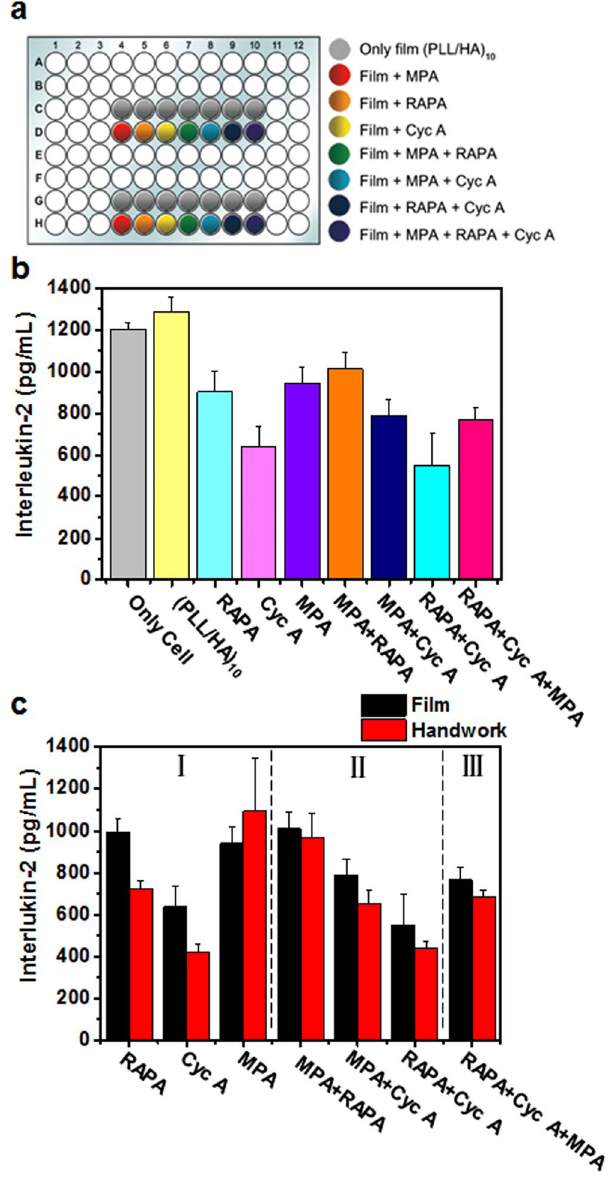
level comparison between the multilayer nanofilms and manual immunosuppressive drug combination